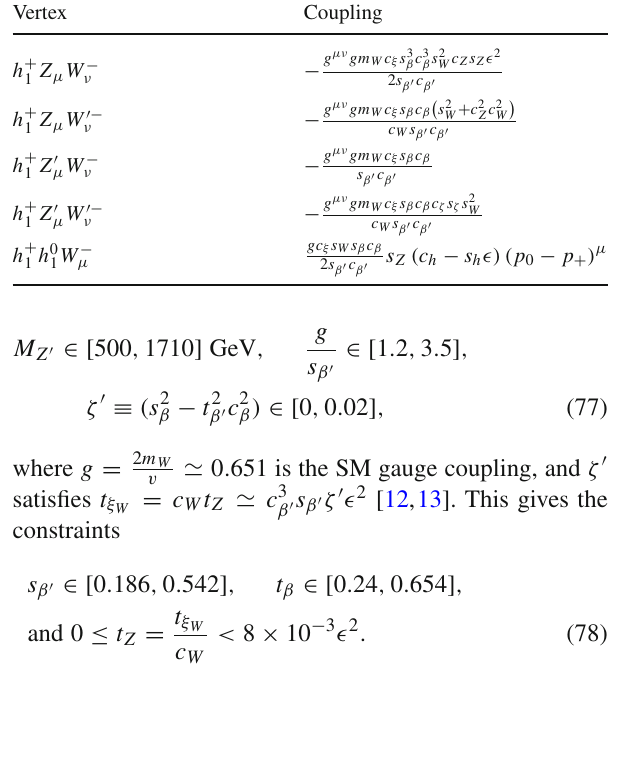
with bosons. Momenta of h + 1